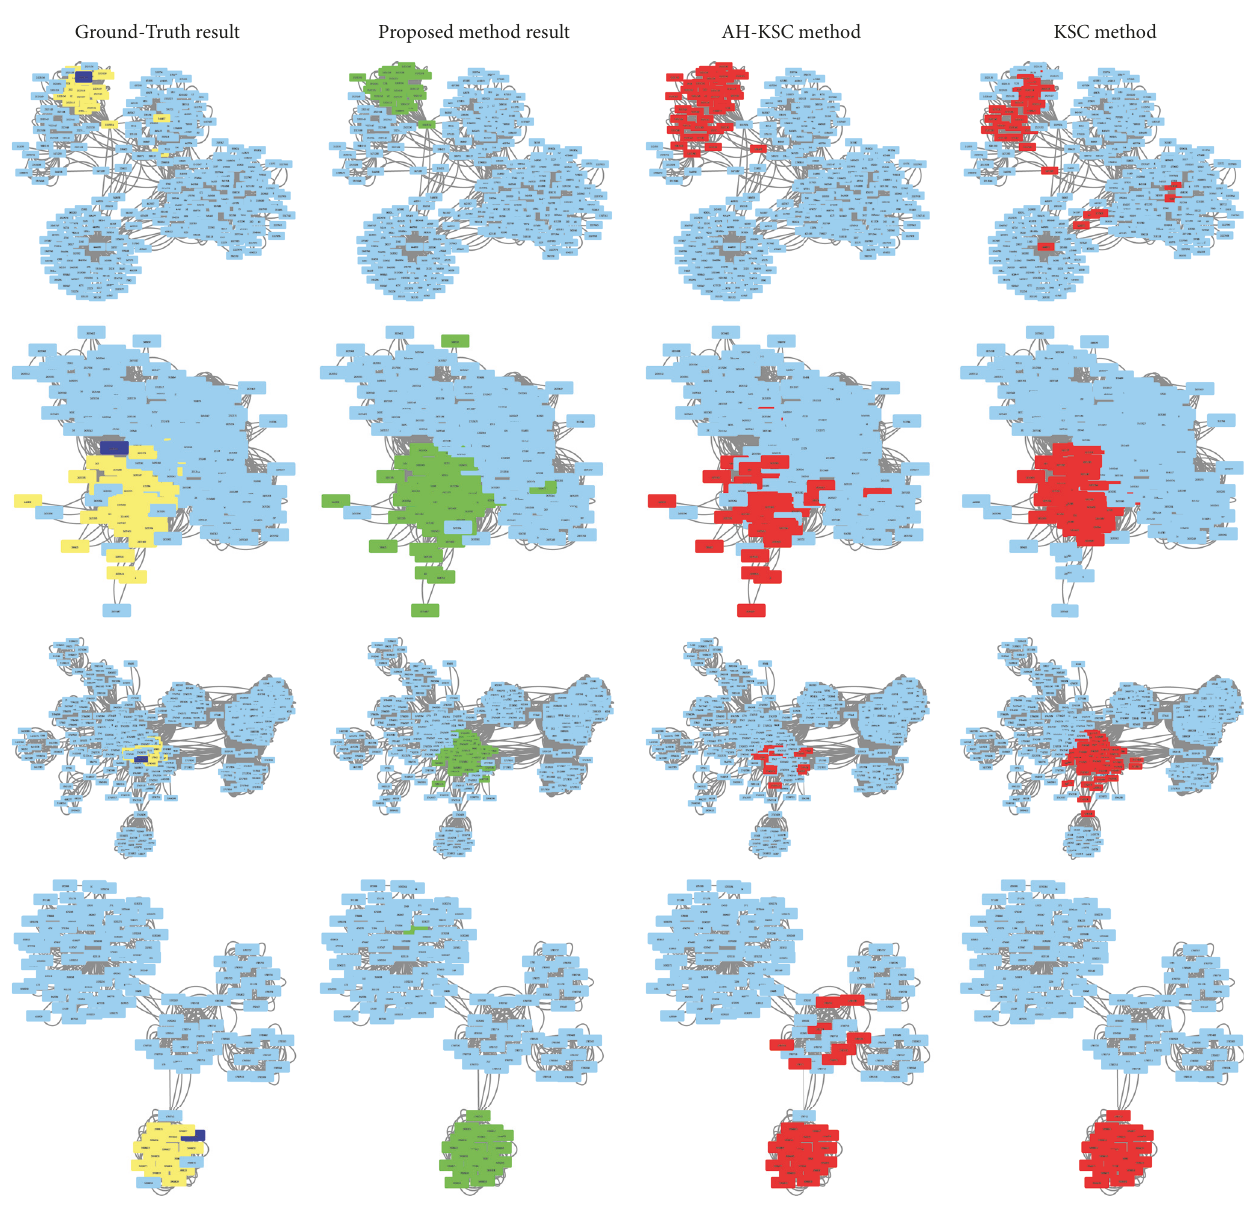
Figure 5: Example of detected community